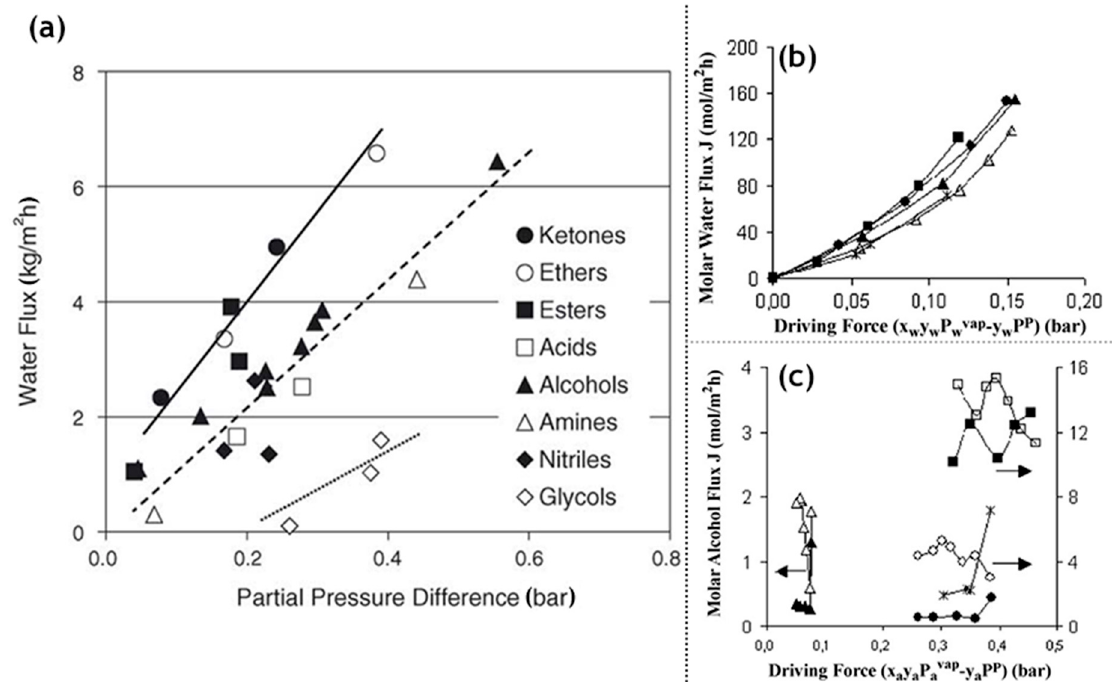
Figure 11. ( a ) Partial permeate flux of water over partial pressure difference for the ECN silica membrane with different systems in pervaporation at a feed concentration of 10 wt % water, a permeate vacuum of 20 mbar and feed temperatures below the boiling point at ambient pressure. Lines are added as a guide to the eye. Adapted from [65], with permission from Copyright (2005), Elsevier B.V. ( b ) Molar water flux as a function of the water driving force at 60°C. Relative error = 6%. ( c ) Molar alcohol flux as a function of the alcohol driving force for aqueous mixtures at 60°C. Relative error = 6%: ( ■ ) M1, ethanol–water, (•)M1, isopropanol–water, ( ▲ )M1, butanol–water, ( Δ )M2, butanol–water, (x) M3, isopropanol–water and ( (cid:3) ) M2, ethanol–water. The full lines are a guide to the eye. Adapted from [74], with permission from Copyright (2010), Elsevier